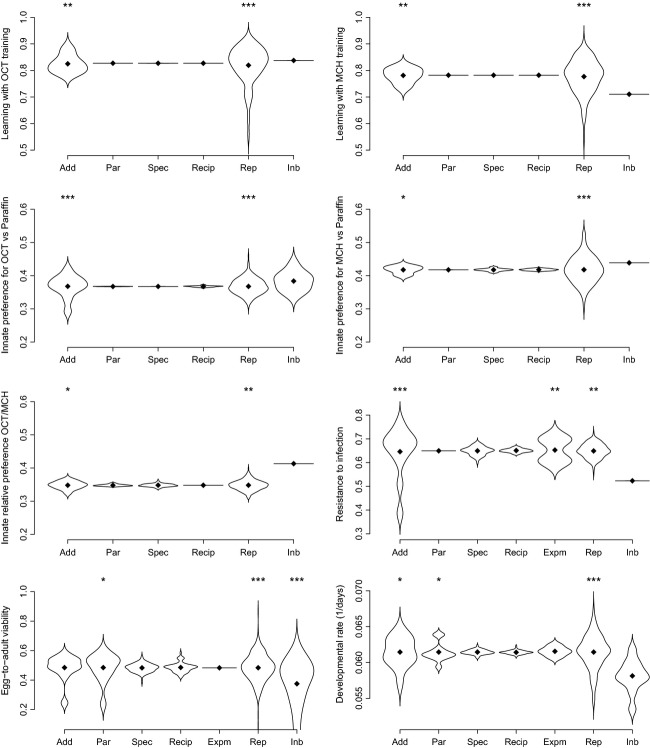
Estimates for additive genetic effects (Add), parental effects (Par), genetic specific effects (Spec), reciprocal effects (Recip), experimenter effects, when relevant (Expm), replicate effects (Rep), and inbreeding effects (Inb). Random effect predictors were back-transformed to the original scale, so that the y axis can be interpreted as probabilities, except for developmental rate (1/days). Distributions of random effects are centered (black diamonds) around their expectation (μ + β for inbreeding effect, μ for all other effects). The distributions of random effects are illustrated by violin plots, estimated with the “density" function in R, with default parameters (Sheather and Jones 1991; R Core Team 2014). The stars reflect the impact of removing individual effects (as in backward model selection) in terms of cAIC differences: *** ΔAIC > 10; ** ΔAIC > 5; * ΔAIC > 2.